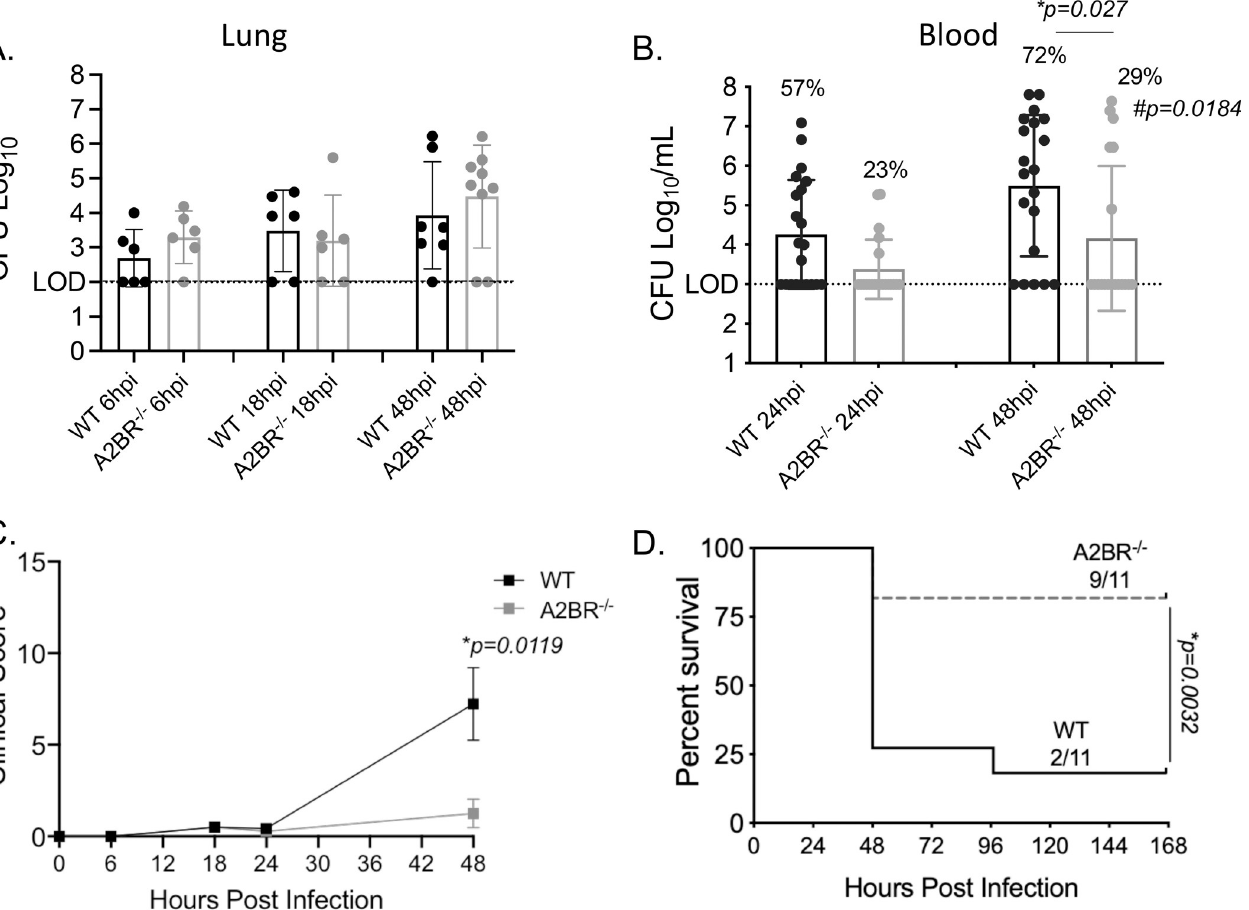
Fig 7. A2BR impairs host resistance against pulmonary infection with S . pneumoniae . A2BR -/- (light grey) and wild type (WT) C57BL/6 (black) mice were infected with S . pneumoniae TIGR4 intra-tracheally. One set of mice were harvested at the indicated hours post infection for enumeration of bacterial numbers in the lungs (A) and blood (B) by plating on blood agar plates. Data are pooled from three separate experiments and each dot represents one individual mouse. � indicates significant differences as measured by unpaired Student’s t-test. The percentages indicate the fraction of mice that became bacteremic and # indicates significant differences between the mouse groups in the incidence of bacteremia as measured by Fisher’s exact test. (C-D) Another set of mice were monitored for clinical signs and symptoms of diseases (clinical score) (C) and survival (D) over time. Data are pooled from three separate experiments with n = 11 mice per group. � indicates significant differences as measured by Mann-Whitney test (C) and Log-Rank Mantle Cox test